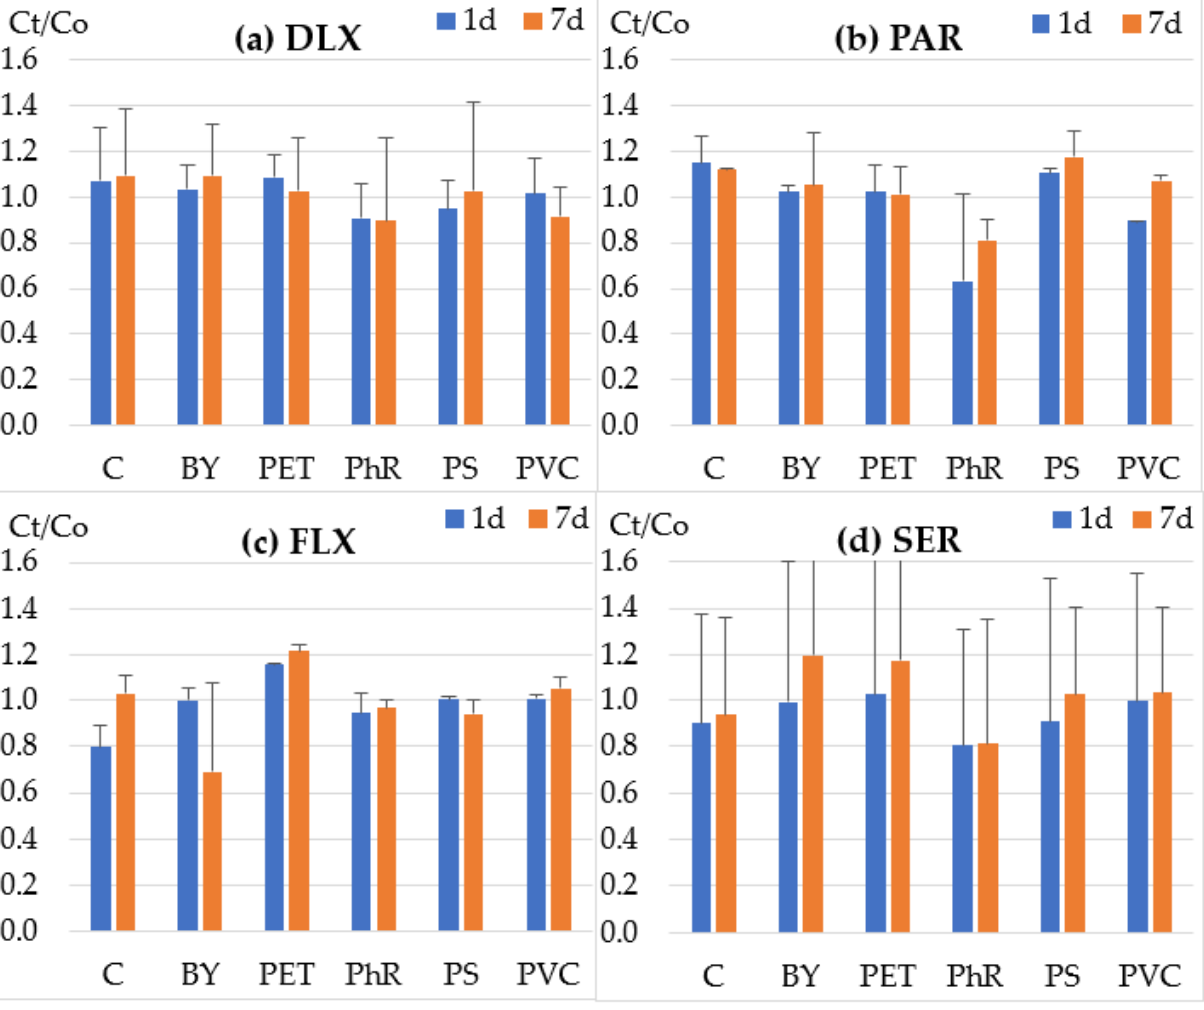
Figure 2. The relative concentration of drugs ( a ) duloxetine, ( b ) paroxetine, ( c ) fluoxetine, and ( d ) sertraline after 1 and 7 d of incubation in microparticle suspensions in relation to the initial level (C 0 ).